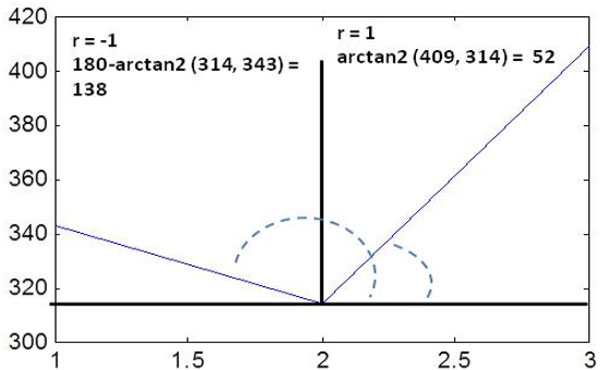
Degree of fluctuation for three expression values of a gene. An illustration of converting the expression values of an expression profile in terms of angular deviation and regulation pattern of edge between two consecutive expression values.